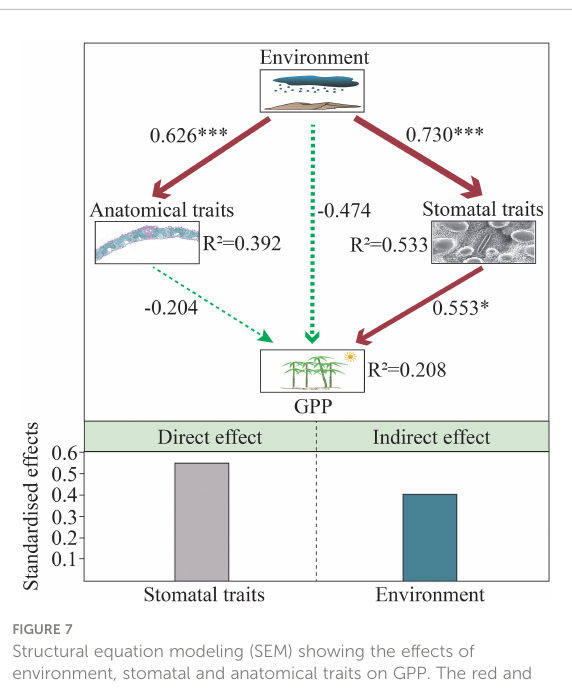
FIGURE 7 Structural equation modeling (SEM) showing the effects of environment, stomatal and anatomical traits on GPP. The red and green arrows represent the positive and negative relationships between the variables, respectively. The width of the arrow is proportional to the intensity, and the number next to the arrow represents the standardized path coef fi